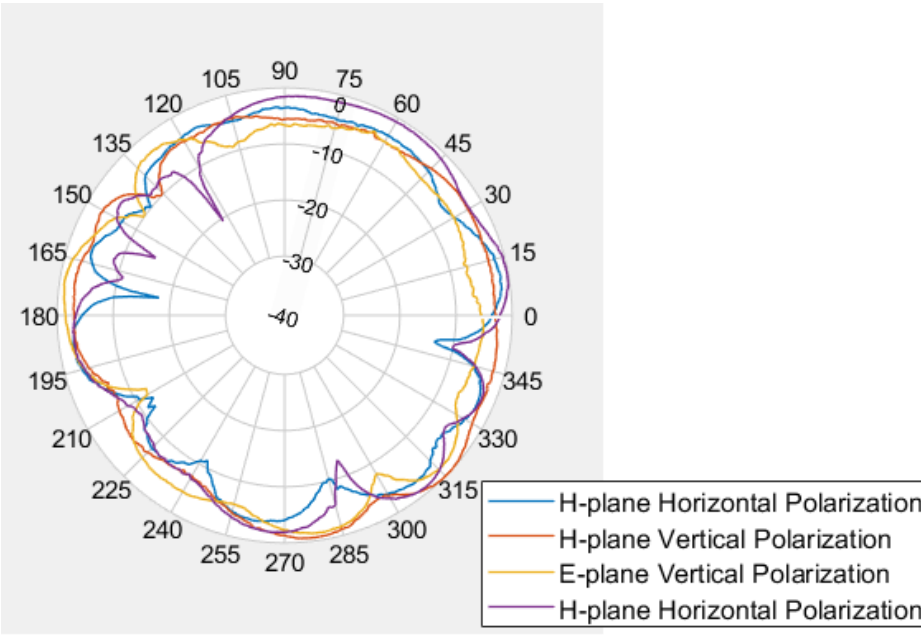
Figure 18. NFP-PCB measured radiation pattern levels normalized in dB.